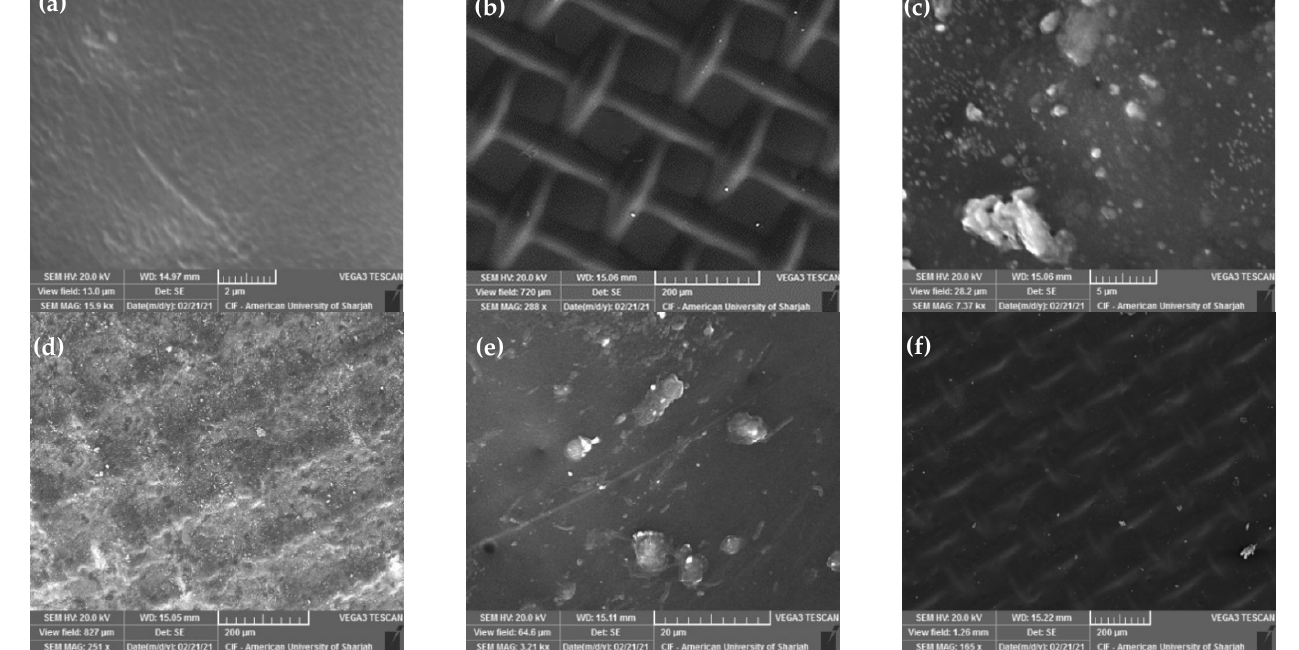
Figure 10. The effect of using ultrasound on water flux through a forward osmosis membrane during desalination of synthetic seawater. SEM images of the original membrane ( a ) active layer and ( b ) support layer; the fouled membrane after the use of a low CFV with the ultrasound facing the support layer (Case 0.25-CC-SL with NaCl draw solution) ( c ) active layer and ( d ) support layer; and the fouled membrane after the use of a high CFV with the ultrasound facing the active layer (Case 1.0-CC-AL with MgCl 2 draw solution) ( e ) active layer and ( f ) support layer [144].